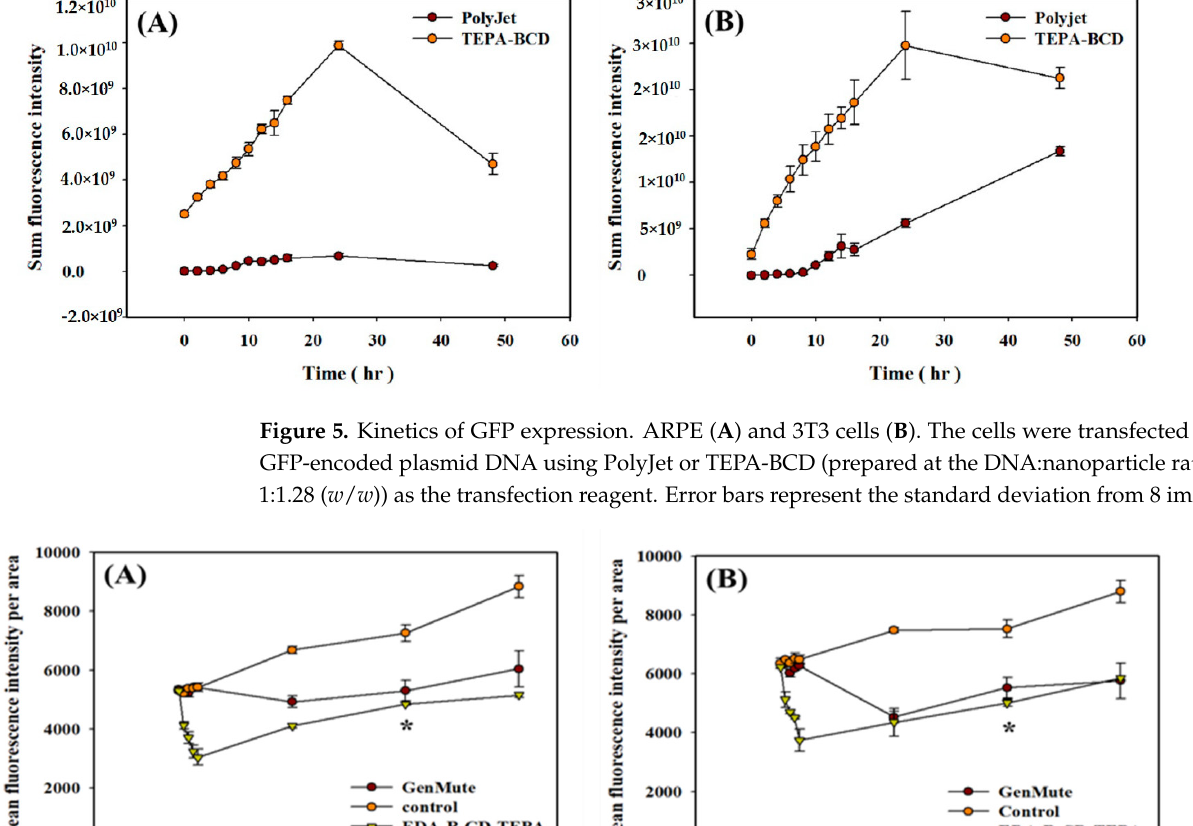
Figure 5. Kinetics of GFP expression. ARPE ( A ) and 3T3 cells ( B ). The cells were transfected with GFP-encoded plasmid DNA using PolyJet or TEPA-BCD (prepared at the DNA:nanoparticle ratio of 1:1.28 ( w / w )) as the transfection reagent. Error bars represent the standard deviation from 8 im- ages. 1.2 × 10 − 10 Table 1. Effects of endocytic inhibitors on DNA uptake and siRNA gene silencing.